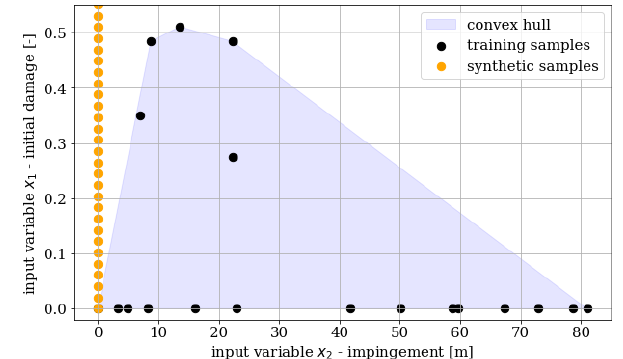
Figure 10. Visualization of the two-dimensional input variable space covered by the available training samples and the correspond- ing convex hull. Synthetic samples were generated along the y axis, where the response is known.